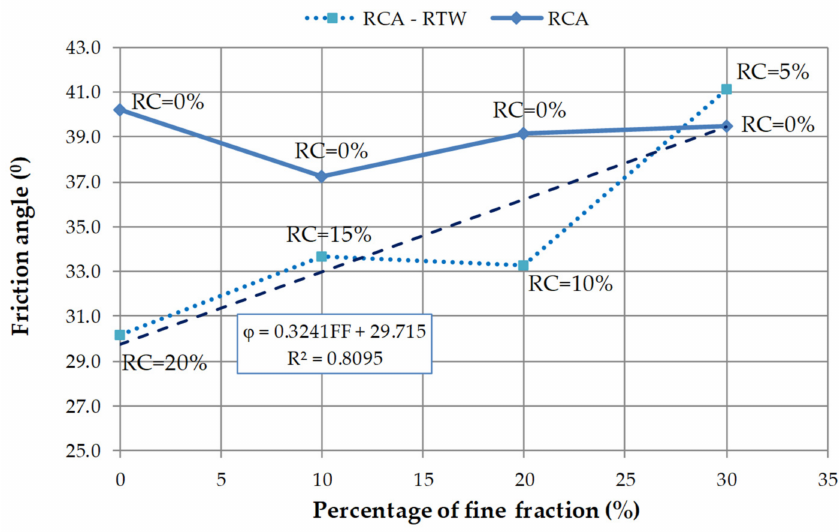
Figure 10. The relationship between friction angle and fine fraction of RCA and RCA–RTW mixtures. Note: RC—rubber content.